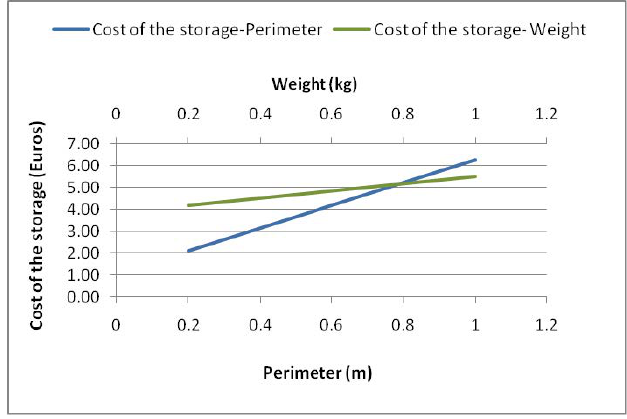
Figure 9. Cost of the storage as a function of the perimeter and of the weight.